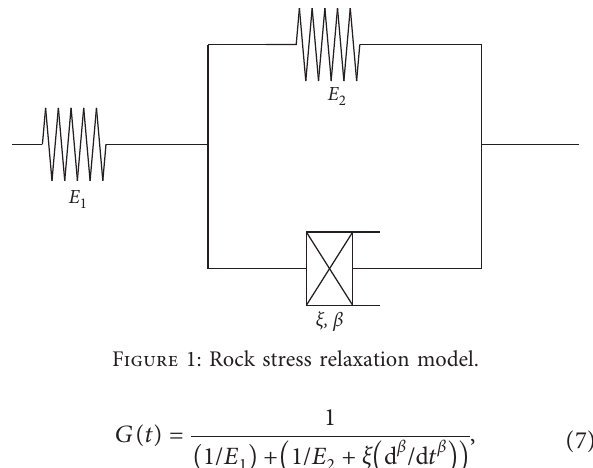
Figure 1: Rock stress relaxation